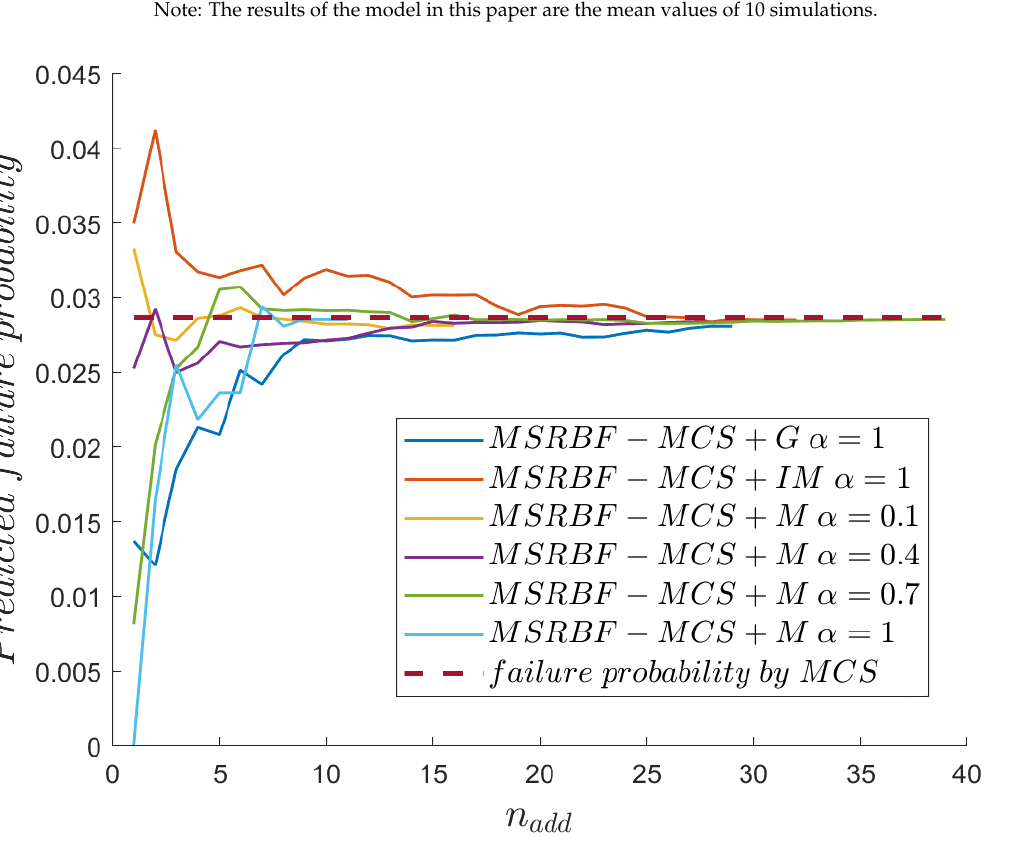
Figure 7. Dynamic response of a nonlinear oscillator.